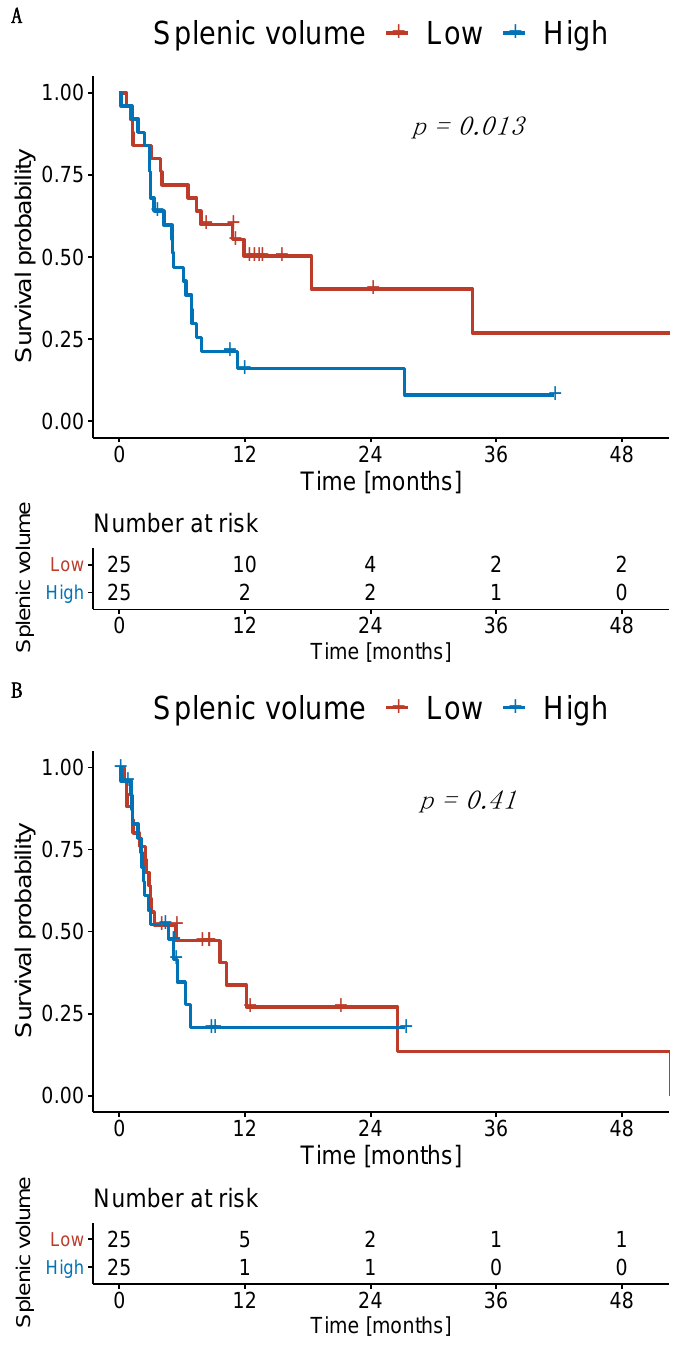
Figure 4. Kaplan–Meier curves for patients with low and high splenic volume. ( A ) Overall survival and ( B ) progression-free survival.